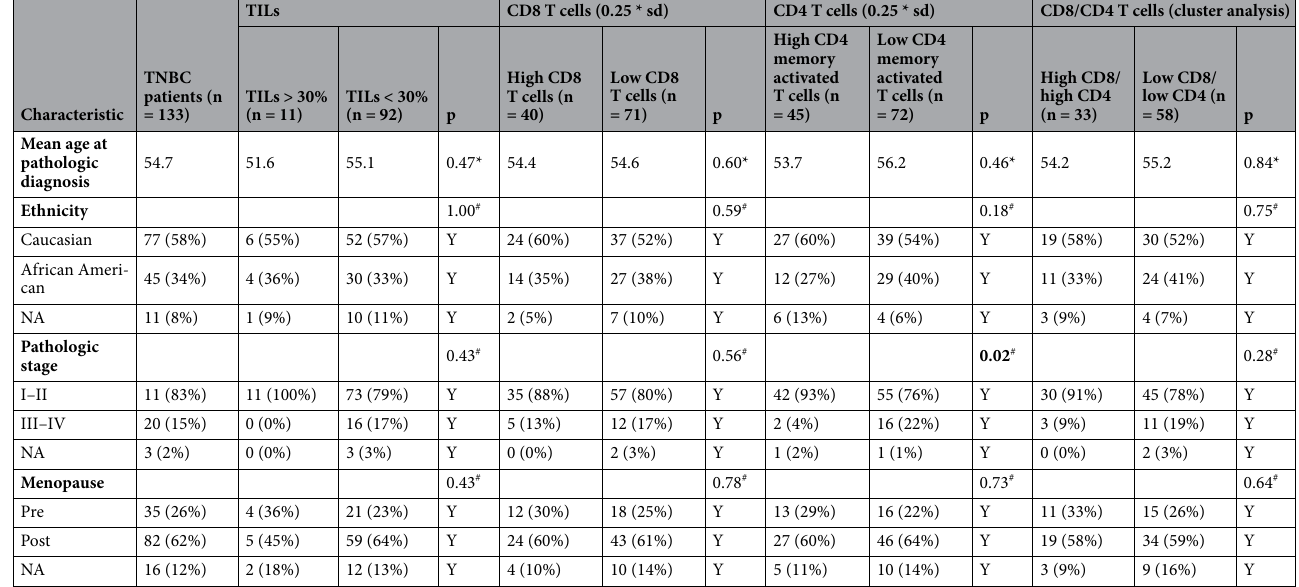
Table 1. Characteristics of TCGA TNBC patients. Bold : pvalue < 0.05. TCGA: The Cancer Genome Atlas; TNBC: triple negative breast cancer; TILs: tumor infiltrating lymphocytes; p: pvalue; sd: standard deviation;